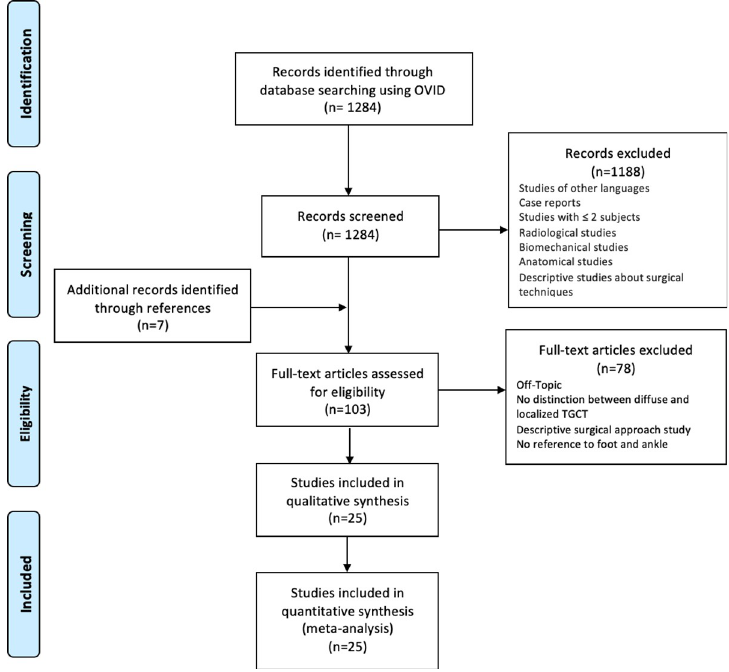
Fig 1. Flowchart of the search strategy and study inclusion, in accordance with the PRISMA